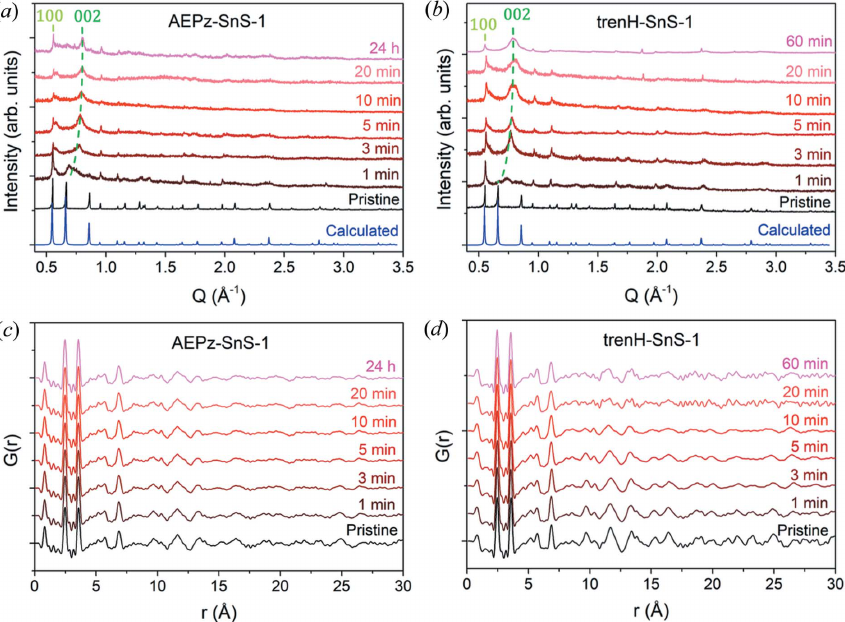
Figure 2 PXRD patterns of pristine and water-treated ( a ) AEPz-SnS-1 and ( b ) trenH-SnS-1. The positions of the (100) and (002) peaks of the pristine samples are shown. The peak at 0.86 A˚ (cid:2) 1 corresponds to (102). The calculated patterns are based on the crystal structure of trenH-SnS-1 (Filsø et al. , 2017). Peaks from a minor